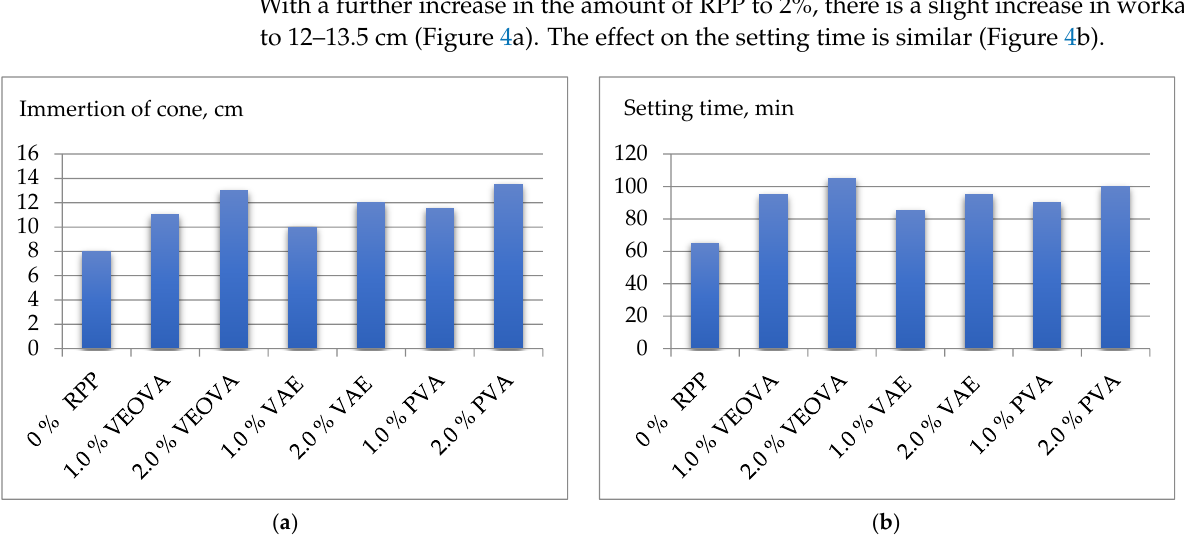
Figure 4. Properties of mixtures using RPP: ( a ) workability; ( b ) setting time.